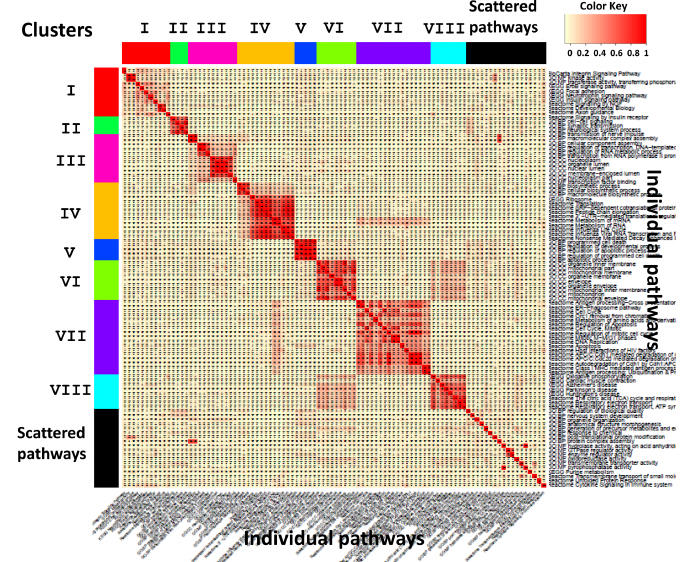
Figure 3. Heatmap of kappa statistics of pair-wise pathways in all clusters.